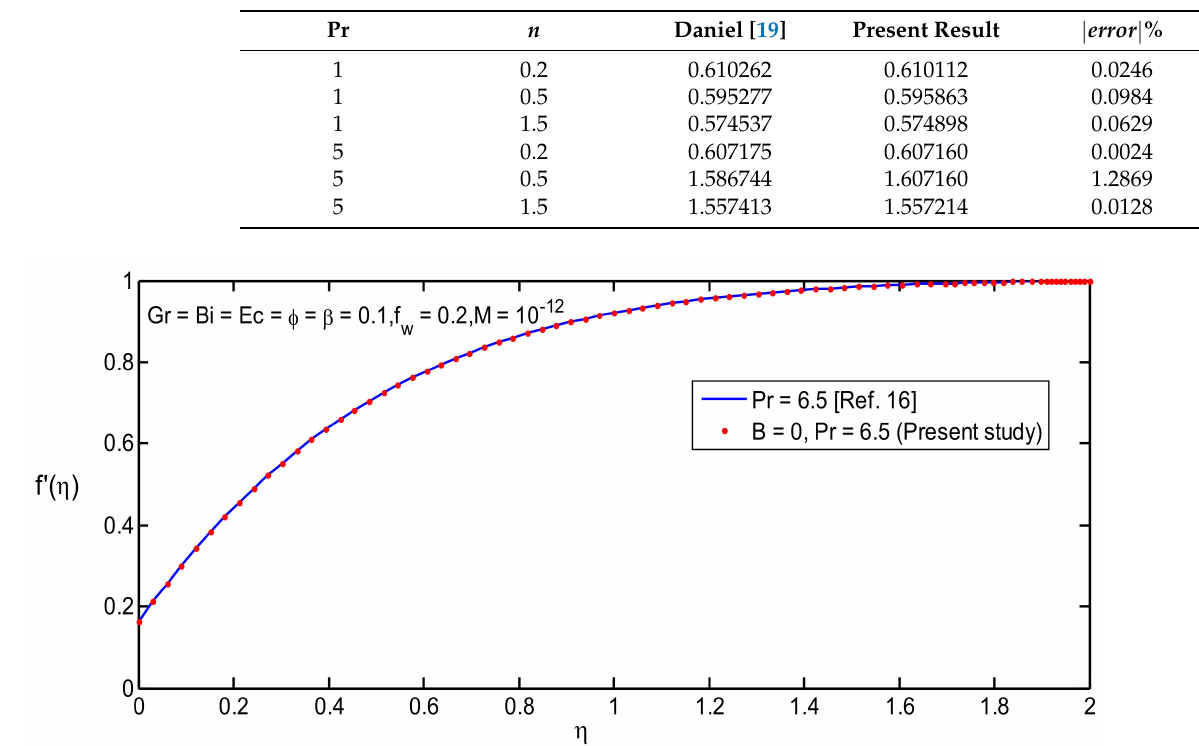
Figure 2. Comparison of velocity profile for B =